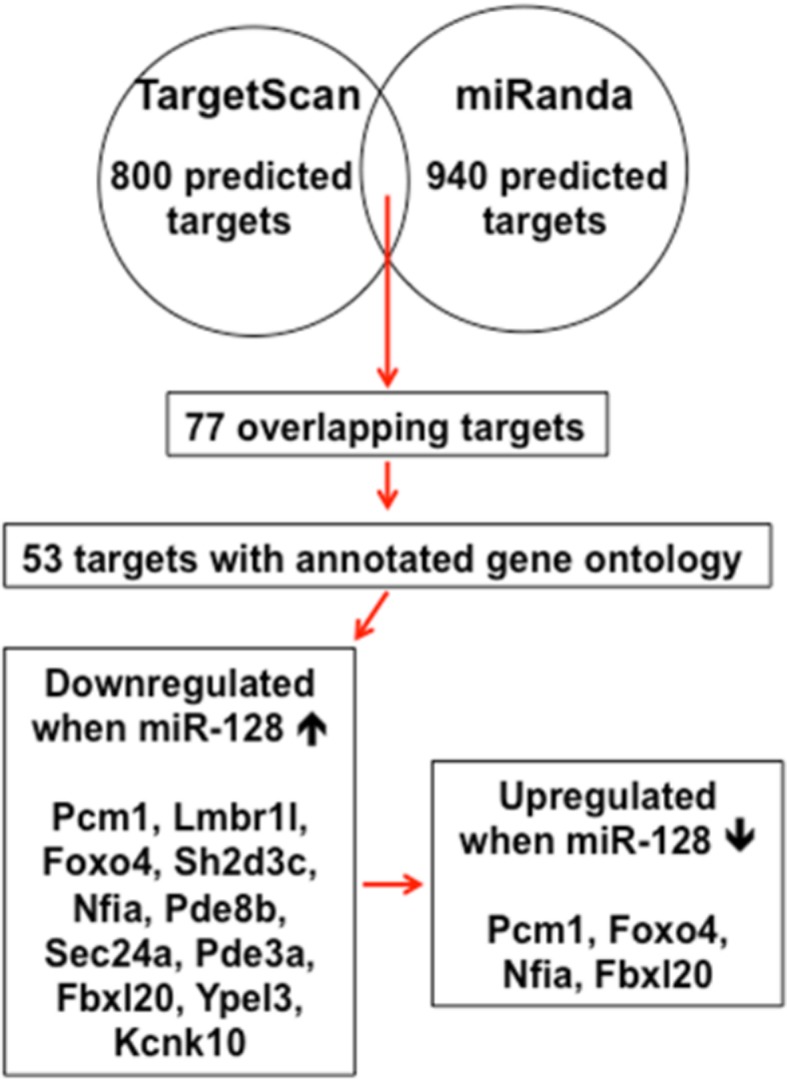
Schematic diagram outlines rationale of gene selection process.Two widely used in silico microRNA target prediction databases (TargetScan and miRanda)(Mi et al., 2013; Witkos et al., 2011) predicted 800 and 940 potential targets of miR-128, respectively. Among the 77 overlapping targets only 53 were annotated to have known biological function and only 11 out of the 53 genes exhibited consistent reduction in mRNA levels upon miR-128 overexpressionin cultured mouse NPCs and were further tested for reciprocal upregulation when miR-128 was inhibited. Lastly, upon miR-128 inhibition in NPCs, only Pcm1, Nfia, Foxo4, and Fbxl20 were consistently upregulated.